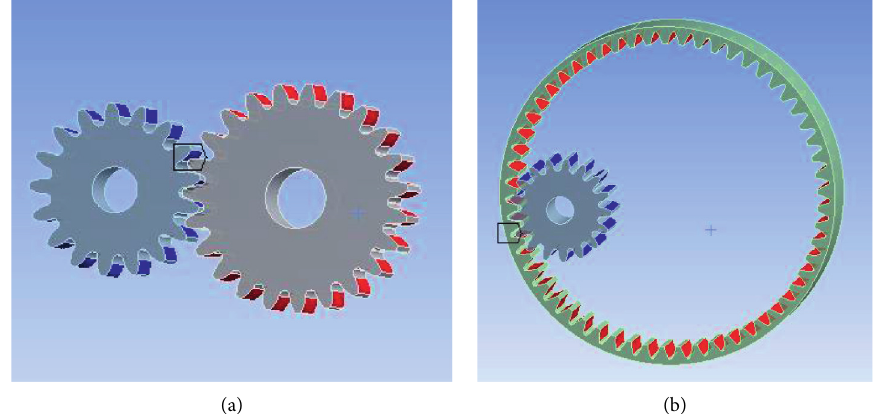
Figure 10: Friction contact pairs in a planetary gear train. (a) The contact pair between the sun gear and the planetary gear. (b) Contact pair of planetary gear and inner ring gear.